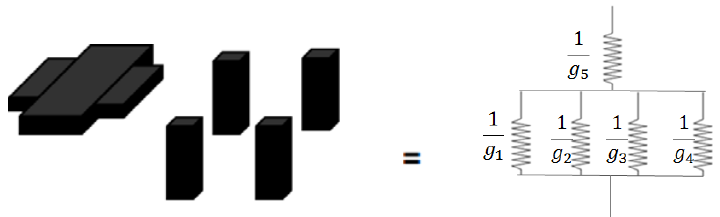
Figure 12. Thermal conductance equivalent